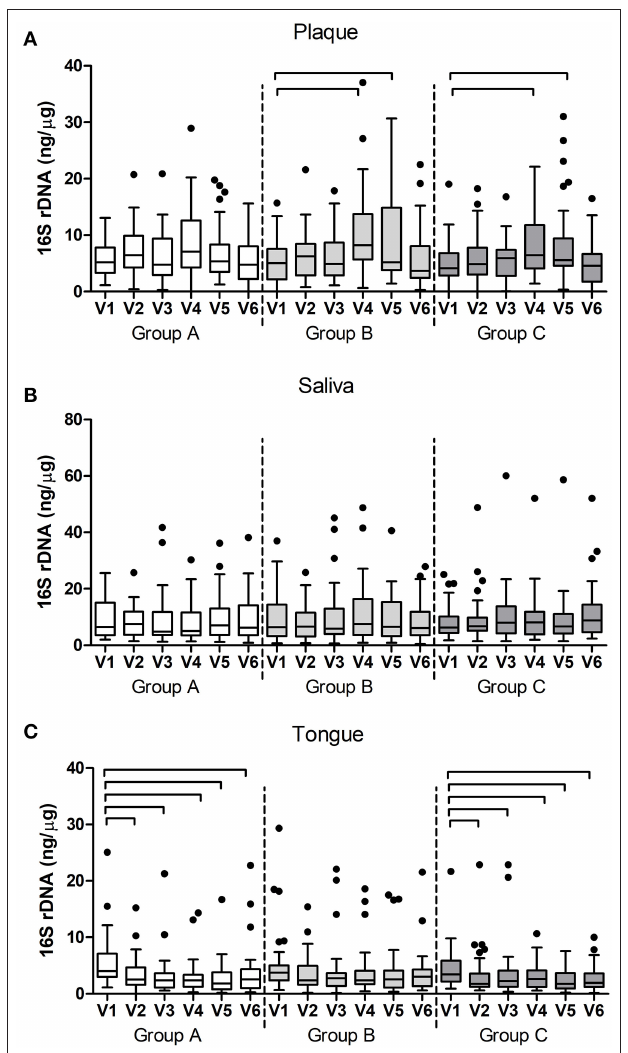
FIGURE 5 | Bacterial DNA (16S rDNA) per group and per visit in (A) dental plaque, (B) salivary and (C) tongue samples. The connectors connect the visits that differed significantly ( P < 0.05, Wilcoxon Signed Ranks test) from the baseline visit.